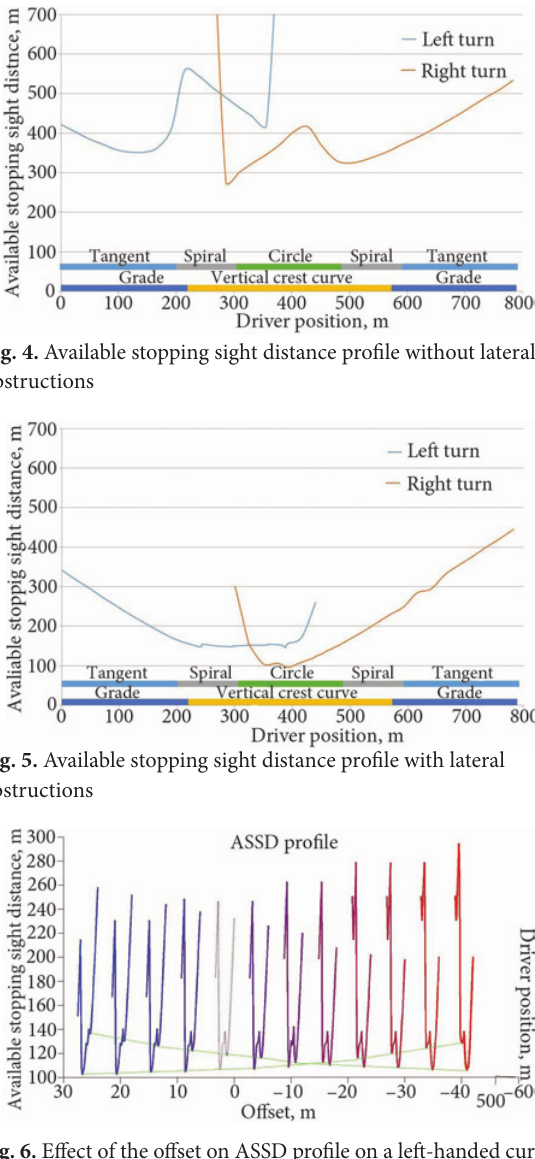
Fig. 6. Effect of the offset on ASSD profile on a left-handed